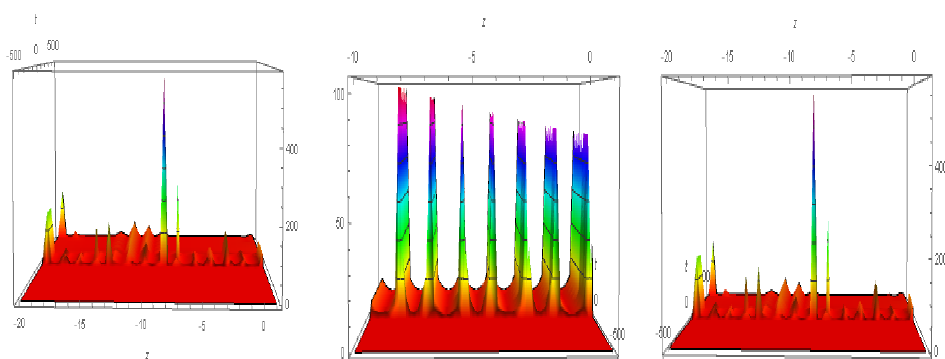
Figure 6. Contour graphs for Figure 5.